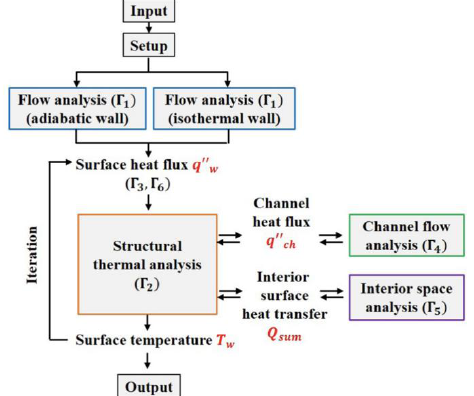
Figure 5. Flowchart of conjugate heat transfer [10].